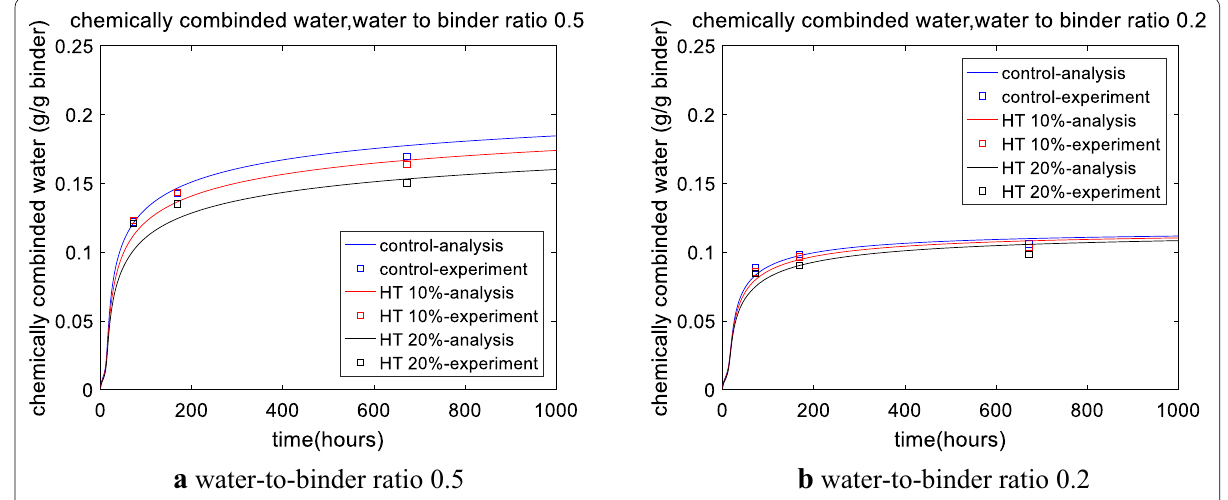
Fig. 5 Combined water content in cement–hwangtoh blends (Lin et al.